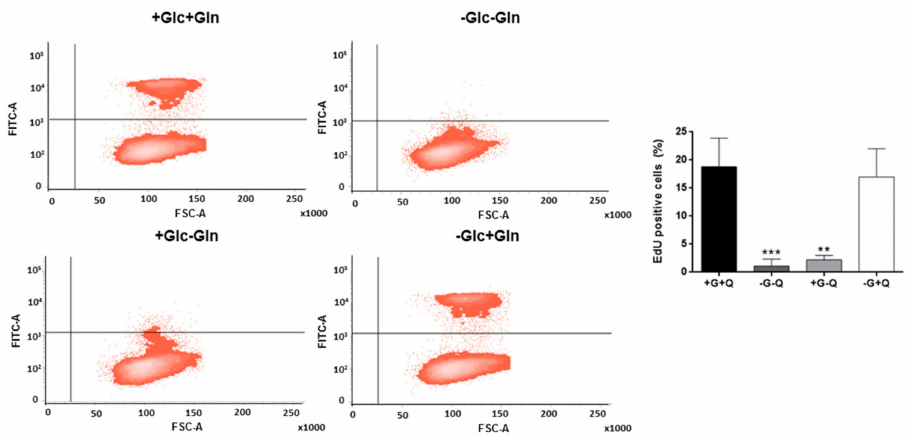
Figure 2. HMEC proliferation under di ff erent nutritional conditions. 10 µ M EdU was added for 2 h to cells already incubated for 22 h in the presence or absence of 5 mM glucose (G) and / or 0.5 mM glutamine (Q). EdU incorporation was detected using a FACS VERSE TM cytometer. Data are expressed as means ± SD of three independent experiments. ** p < 0.01, *** p < 0.001 versus condition with glucose and